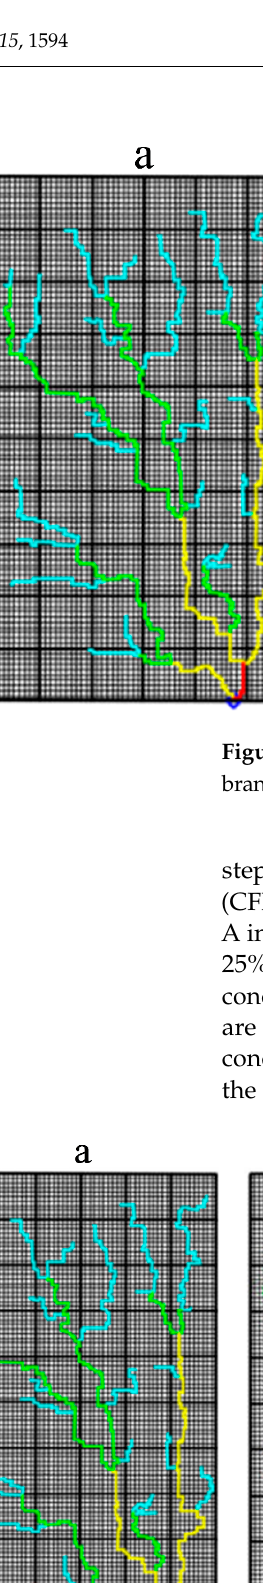
A2: Rectilinear branchwork A3: Network maze 9 Point Re- charge (0%) Diffuse Re- charge (100%) B1: the base model, including A1, A2, and A3 Conduit density Hydrogeological characteristics of the aquifer (K, T, and S), K- exchange, Conduit pattern, Boundary conditions (No flow boundary, Fixed head bound- ary, Karst spring), and Type of recharge Scenario B B2: 25% reduction in the length of the base model, in- cluding A1, A2, and A3 B3: 50% reduction in the length of the base model in- cluding A1, A2, and A3 B4: 75% reduction in the length of the base model, in- cluding A1, A2, and A3